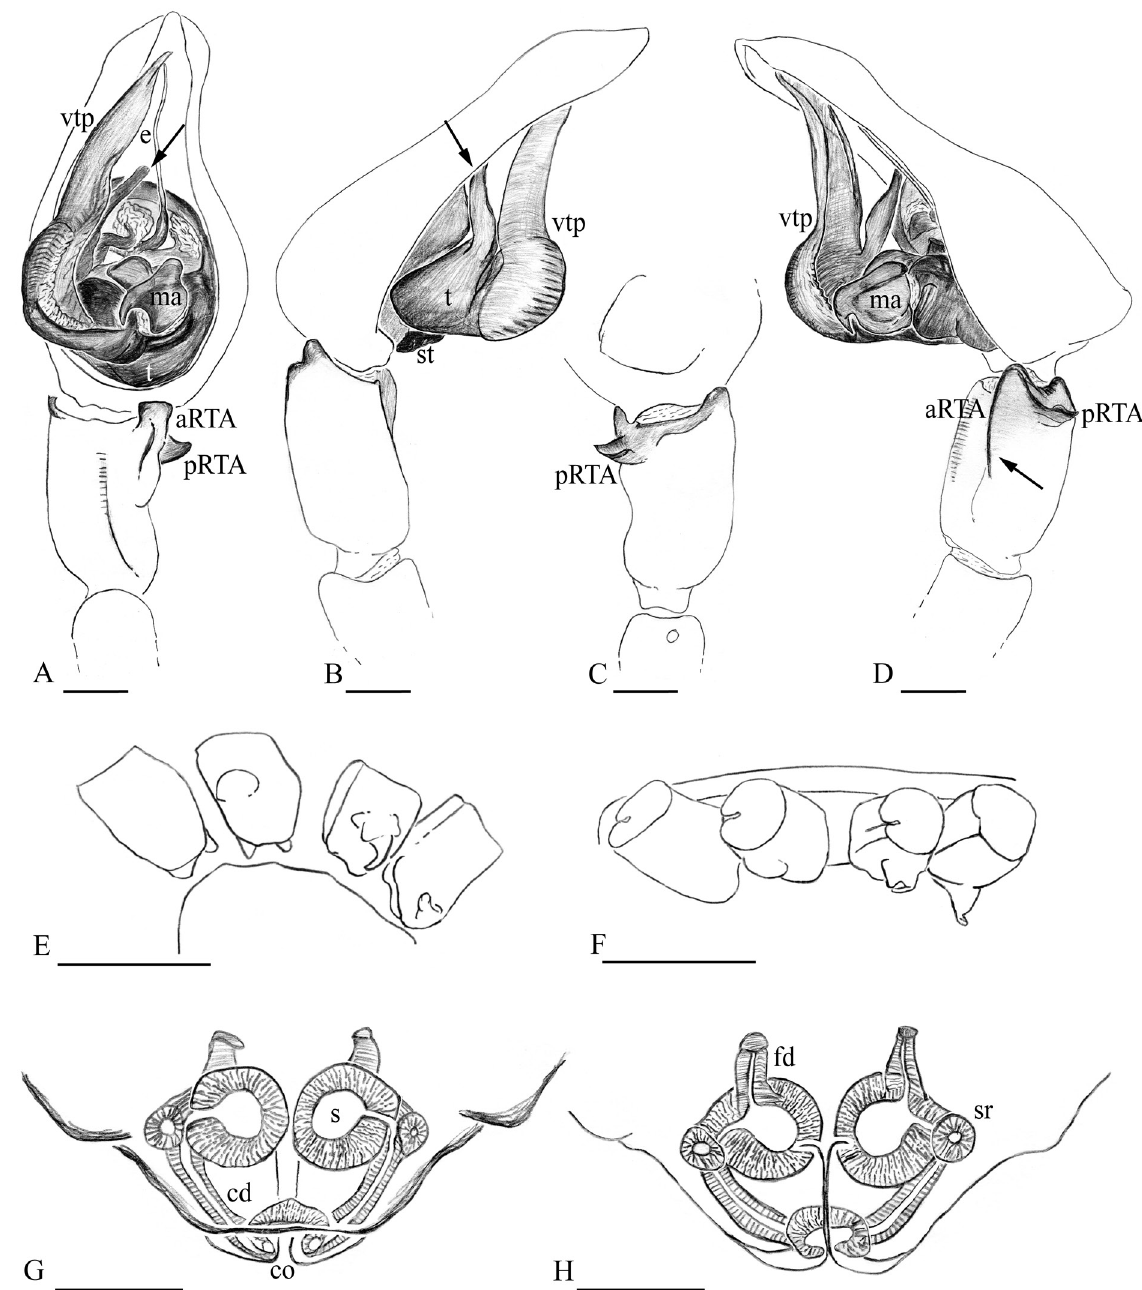
Fig. 21. Anyphaena bifurcata sp. nov. A–F . Paratype, ♂ (CNAN-T01549). G–H . Paratype, ♀ (CNAN-T01550). A . Pedipalp, ventral view. B . Pedipalp, prolateral view. C . Pedipalp, dorsal view. D . Pedipalp, retrolateral view. E . Coxae, ventral view. F . Coxae, lateral view. G . Epigynum, ventral view. H . Epigynum, dorsal view. Scale bars: A–D, G–H = 0.2 mm; E–F = 1.0